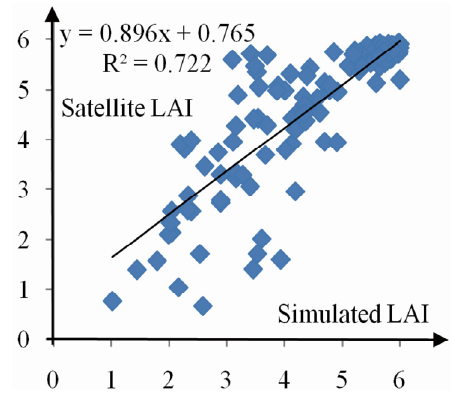
Figure 7. Scatterplot of satellite and simulated monthly basin average LAI. Forests 2016 , 7 , 30